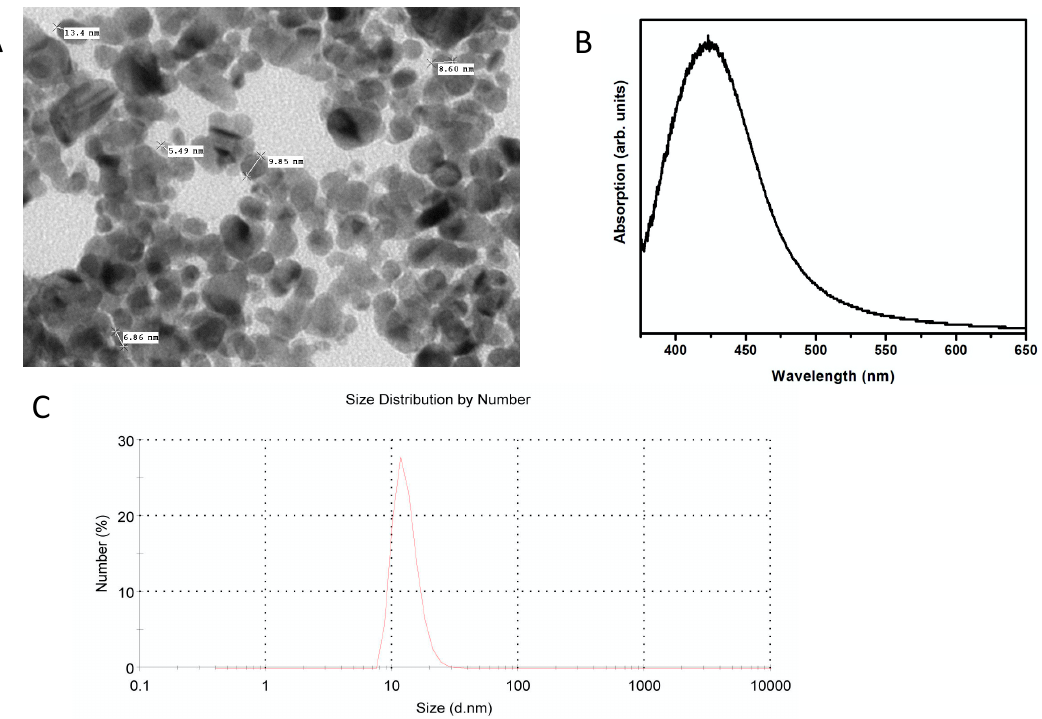
Figure 1. Characterization of the synthesized AgNPs. Synthesized AgNPs were characterized using ( A ) TEM imaging, ( B ) surface plasmon resonance, and ( C ) dynamic light scattering (DLS) for the determination of the hydrodynamic diameter. Table 1. SBS (MPa) of the bracket to enamel in the groups (n = 30/group). Group